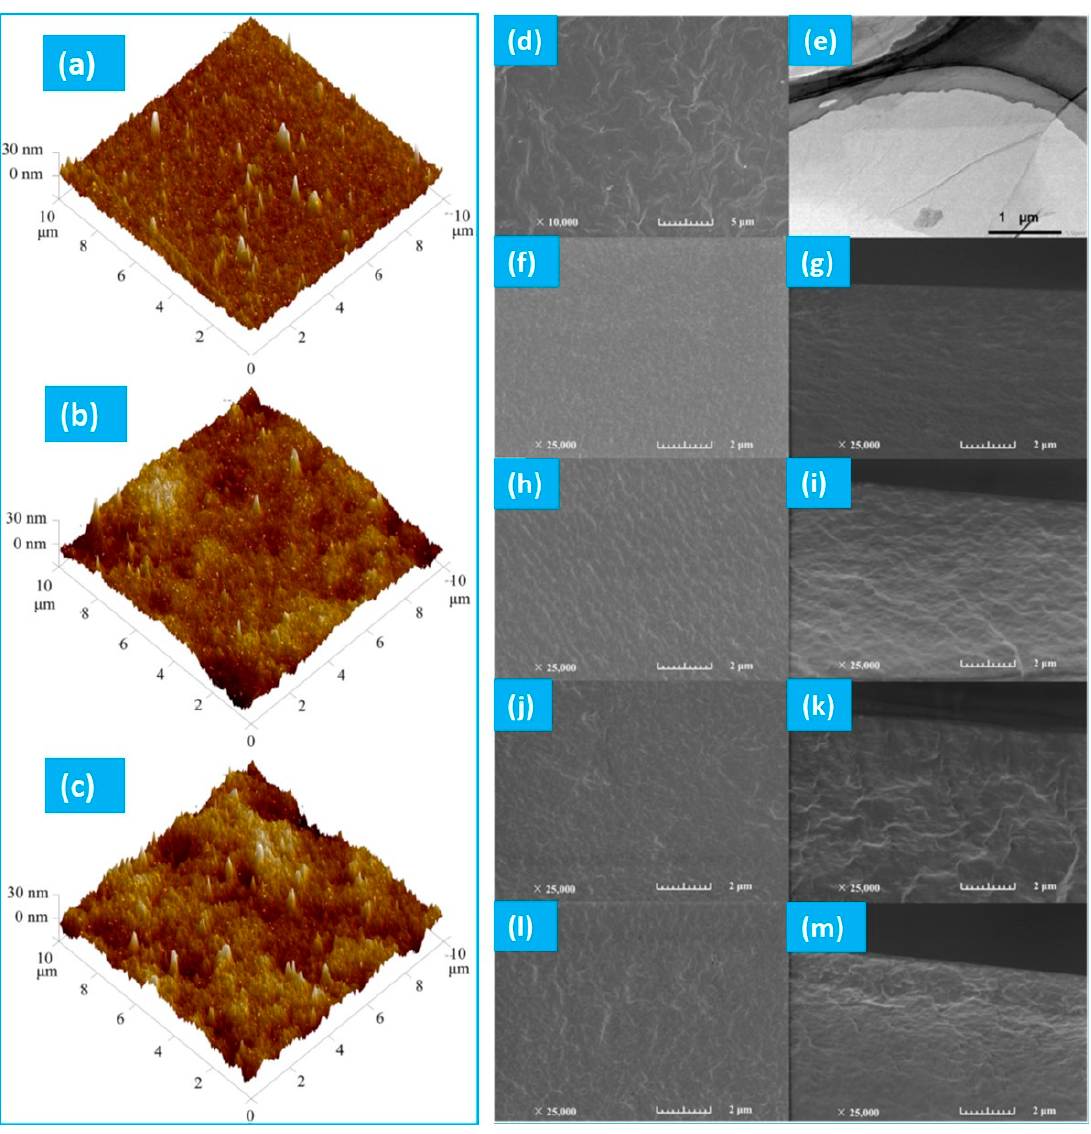
Figure 14. AFM images of ( a ) pristine CS membrane, ( b ) CS / GO-1, and ( c ) CS / GO-2 MMMs. ( d ) SEM and ( e ) TEM of GO and SEM images of the top surface and cross-section of ( f , g ) CS, ( h , i ) CS / GO-0.5, ( j , k ) CS / GO-1.5, and ( l , m ) CS / GO-2 membranes. Reprinted with permission from [136]. Copyright 2018 Elsevier B.V.